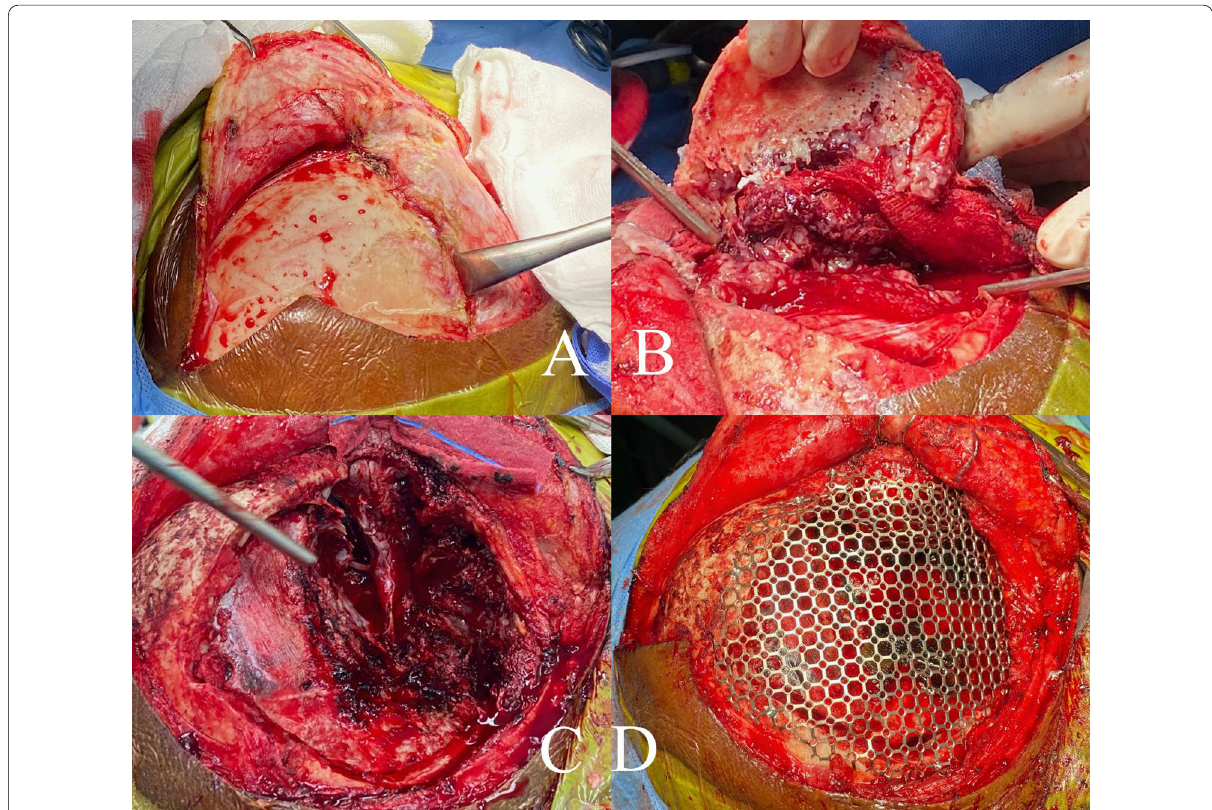
Fig. 4 Top row—intraoperative images showing exposure of temporalis ( A ) and tumour overlying dura and invading temporalis muscle and temporal bone ( B ). Bottom row—post‑resection cavity ( C ) and skull reconstruction with titanium mesh ( D